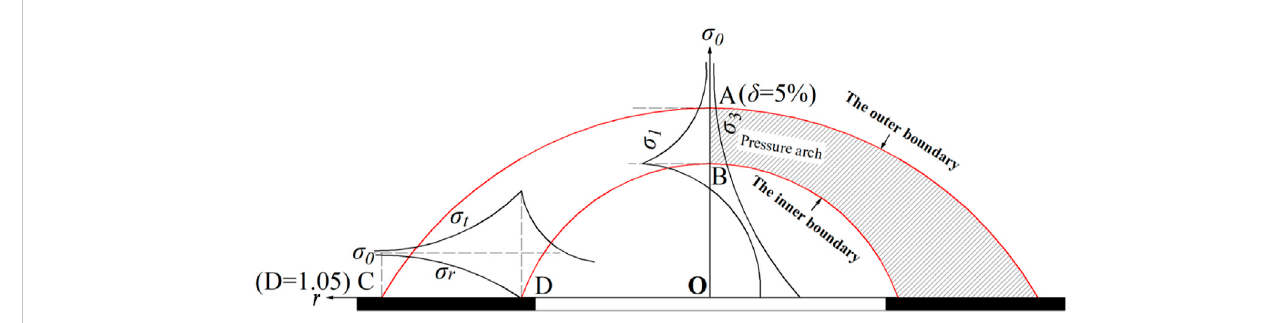
FIGURE 8 Location of inner and outer boundaries of different stress paths in the SRPA (Surrounding rock pressure arch).